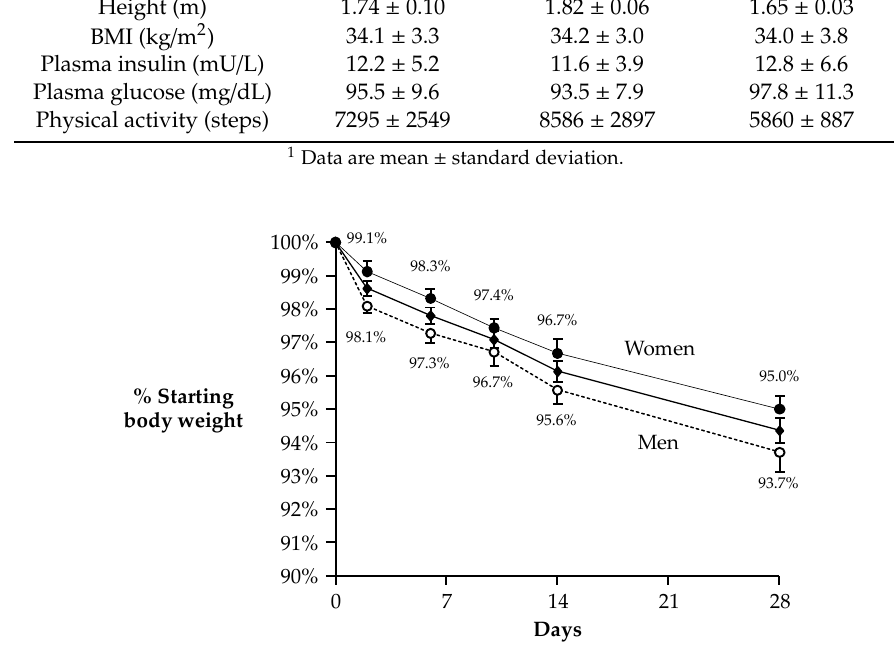
Table 1. Baseline characteristics of study participants 1 .